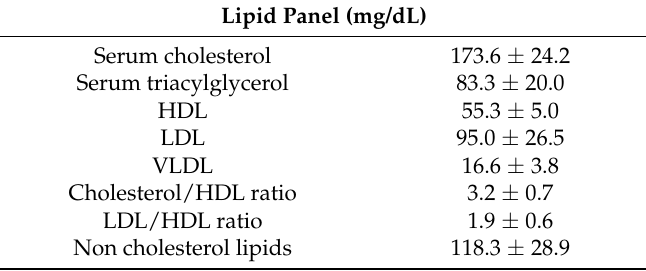
Table 2. Lipid panel values–high-density lipoprotein (HDL); low-density lipoprotein (LDL); very low-density lipoprotein (VLDL)-were assessed as described in materials and methods and are shown here as mean ± standard